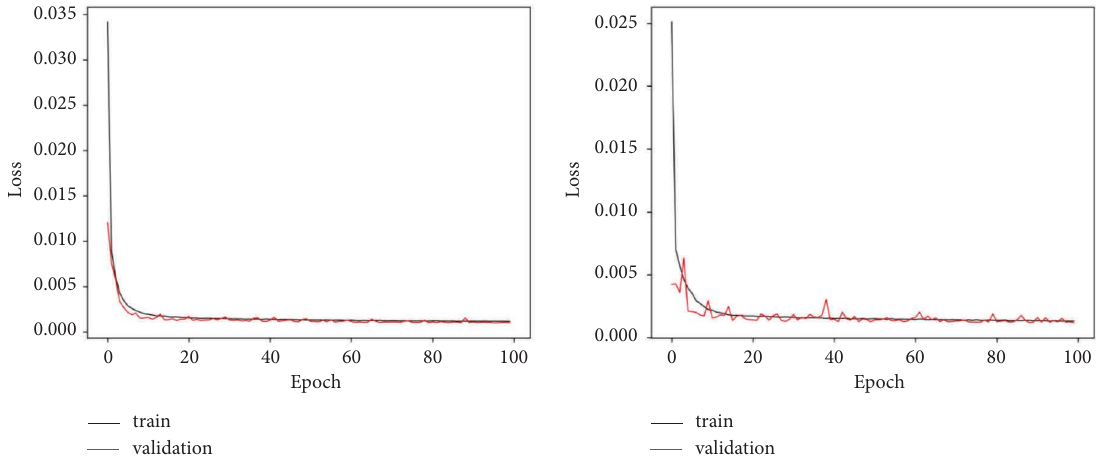
Figure 3: Te loss rates of GRU (a) and SAEs (b). Table 1: Performance comparison of diferent models.